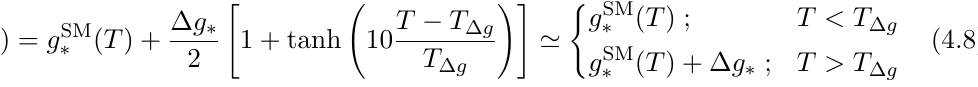
Figure 11 . Modification to the GW spectrum from a global string network due to an increase in the number of relativistic degrees of freedom above T η = 10 15 GeV, α = 0 . 1 , and ∆ g ∗ = 0 , 10 2 , 10 3 (shown in black, red, and blue, respectively). The relevant experimental sensitivities are also